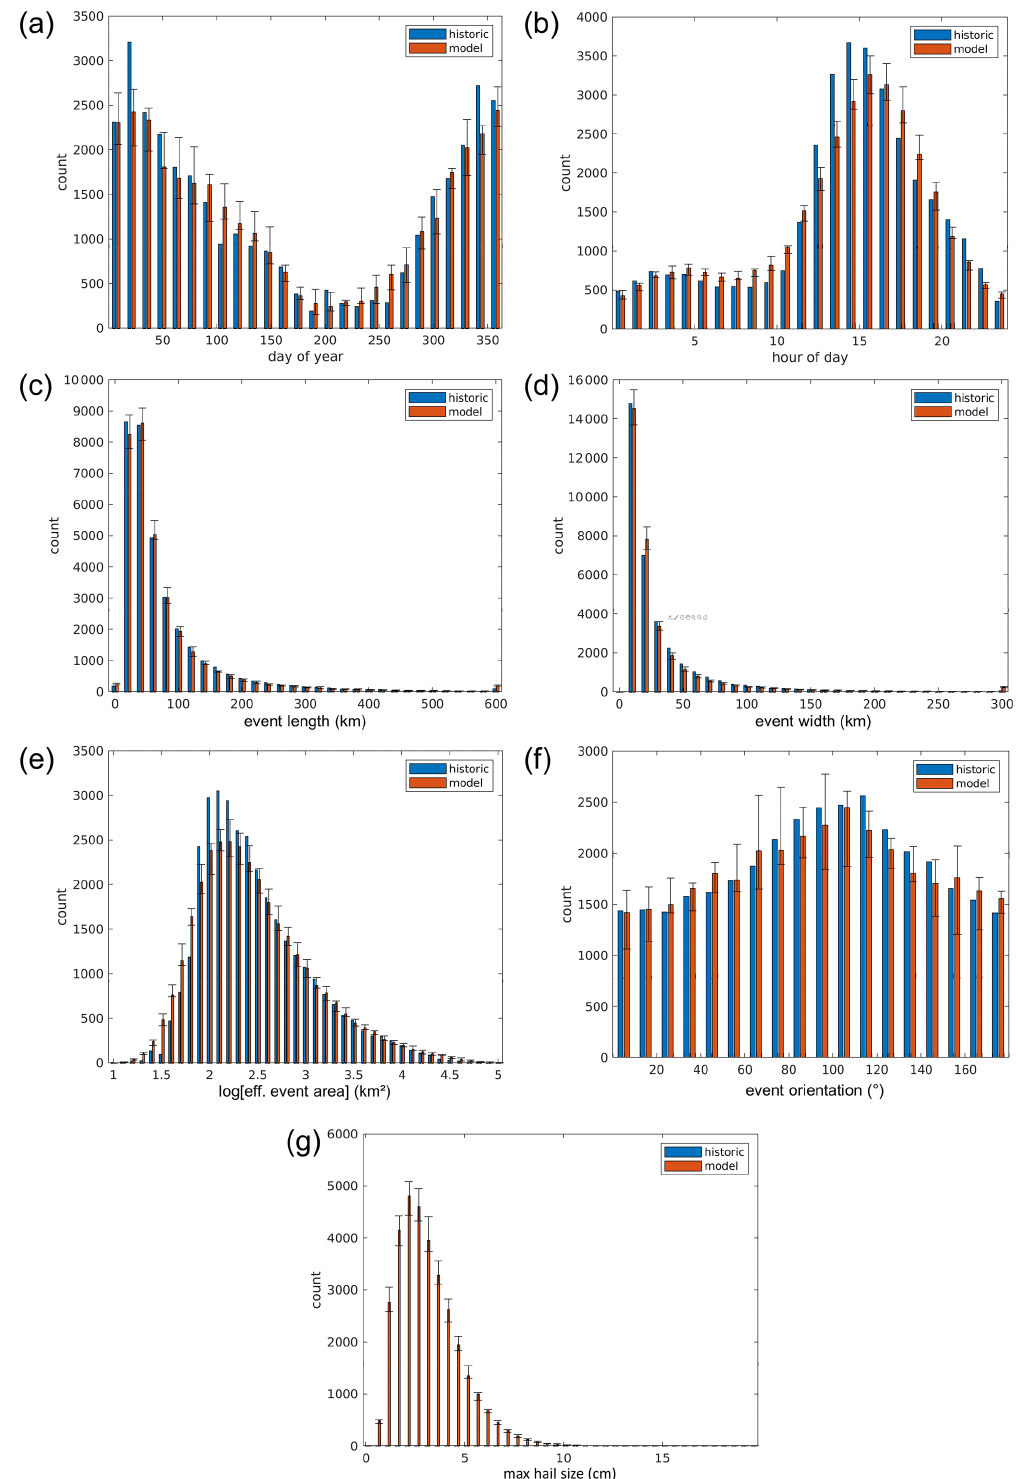
Figure 10. Distributions of properties of historic and stochastic events for (a) day of the year, (b) hour of the day, (c, d) event length and width, (e) affected area, (f) orientation of the events, and (g) maximum hail size. With modeled events, (error) bars indicate the median (spread) among seven independent samples of 14 years’ length. Each set of bars represents 14d, 1h, 20km in length, 10km in width, 0.1 on the log scale of part (e) , and 10 ◦ in orientation. Since hail severity information is essentially unknown for the historic events, blue bars are missing in (g)